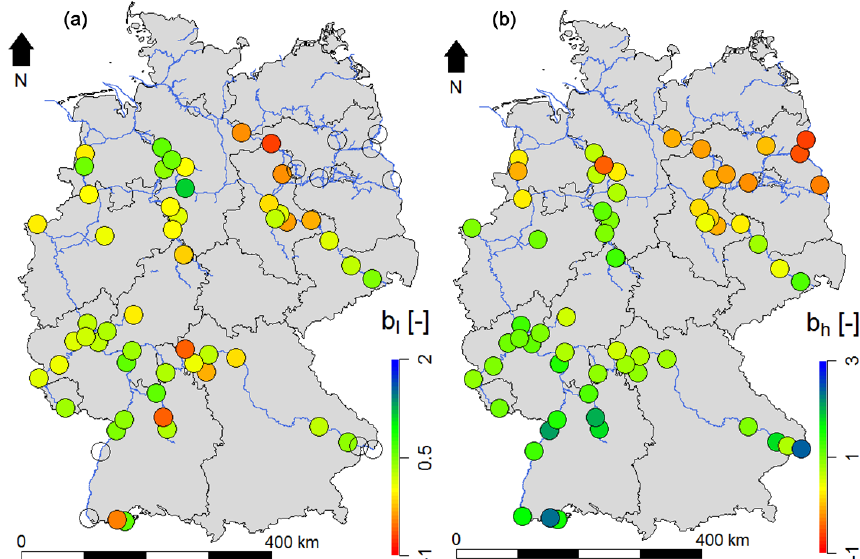
Figure 6. Maps representing the spatial distribution of the rating exponents. Panel (a) indicates b l and panel (b) indicates b h . Empty circles in (a) denote stations without a significant rating break.